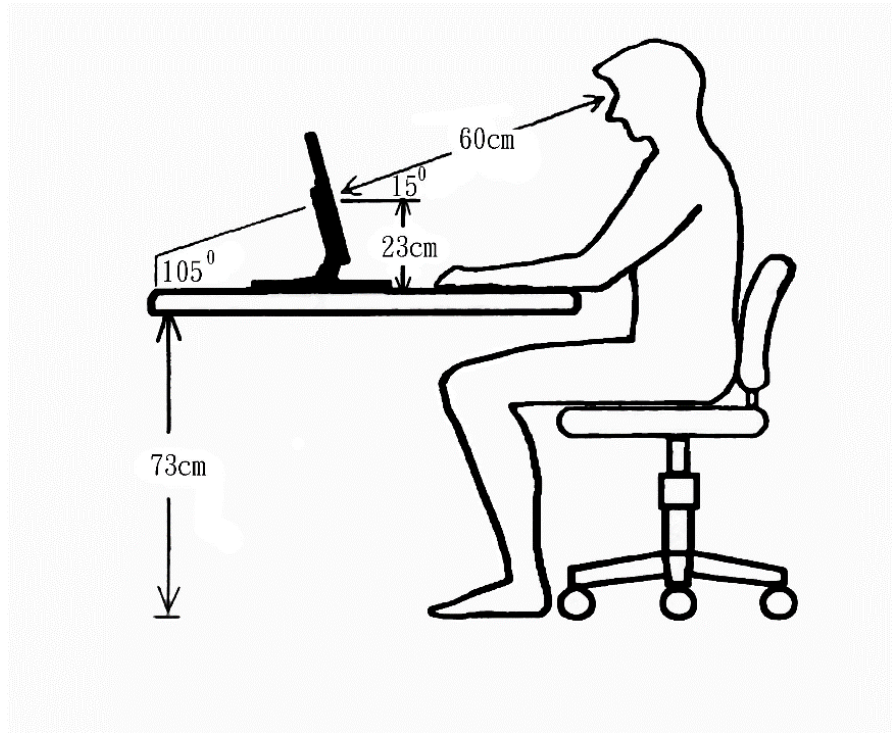
Figure 3. VDT workspace layout. (Source: this study).